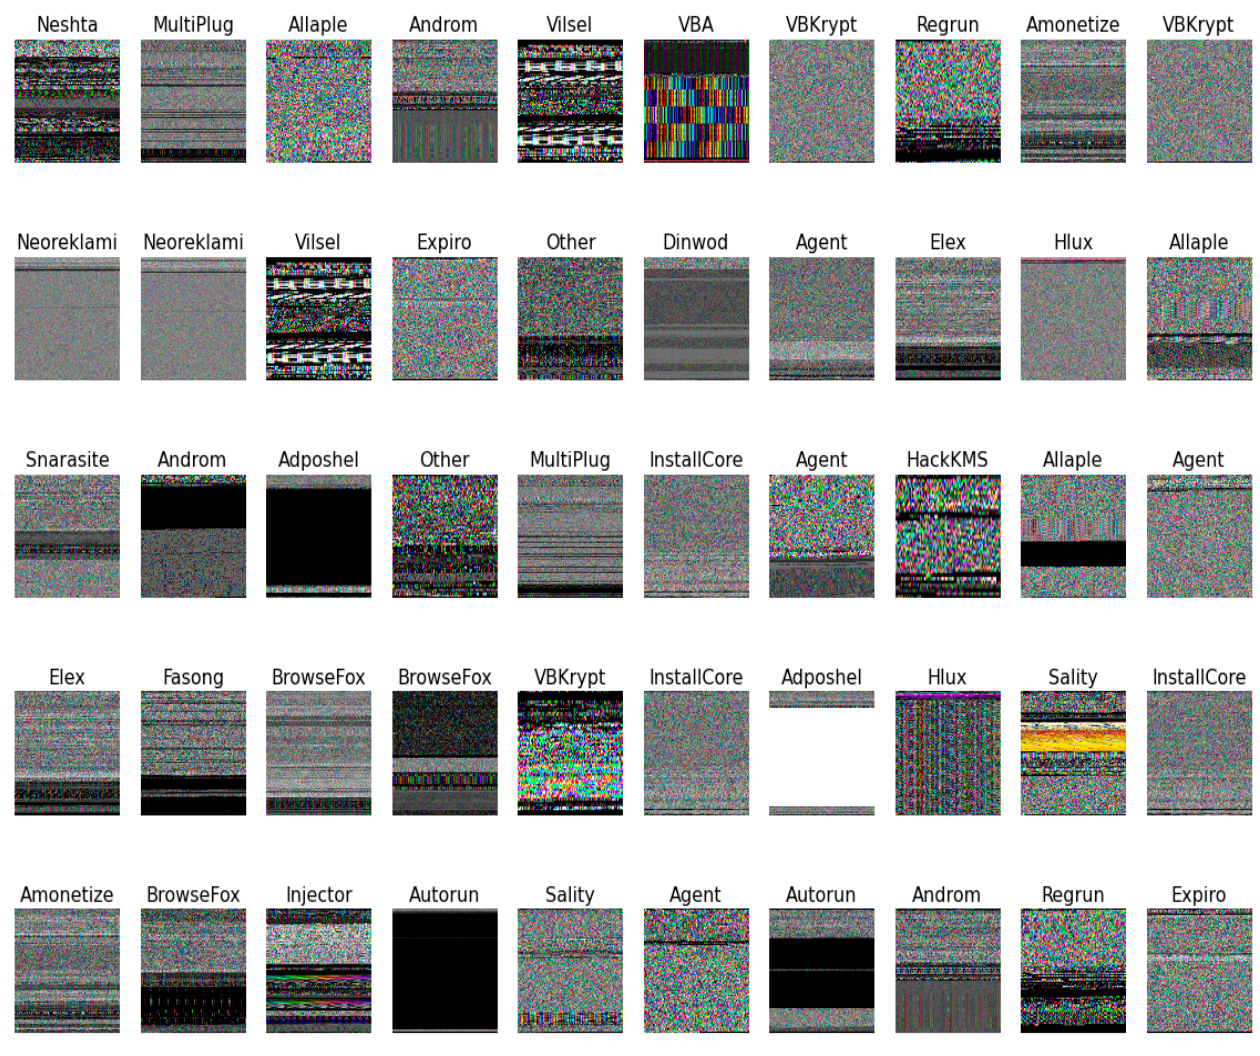
Figure 5. Malware classes in the dataset.